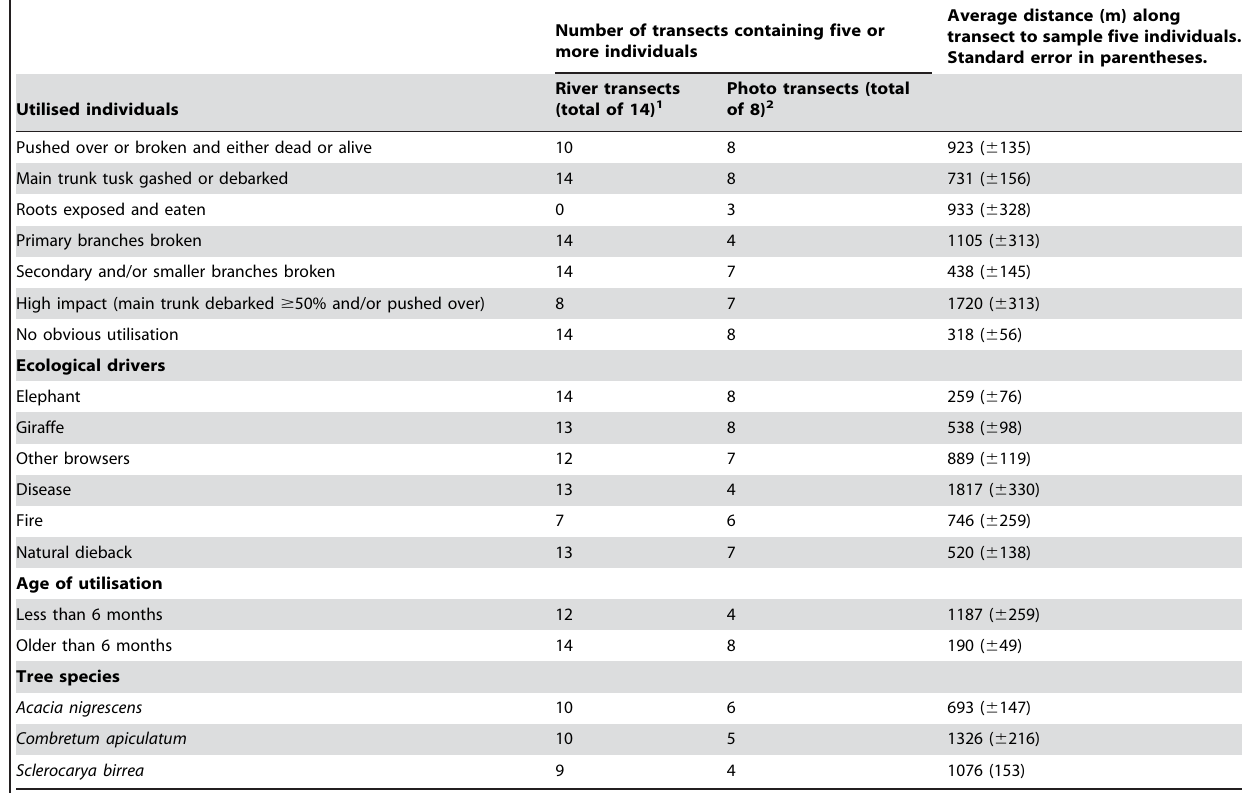
Table 1. The number of transects and the average distance required to sample five individual trees exhibiting the same type of elephant use, to sample five individuals used or modified by the same ecological driver, to sample five individuals exhibiting use less and greater than six months and to sample five individuals of three locally abundant tree species.